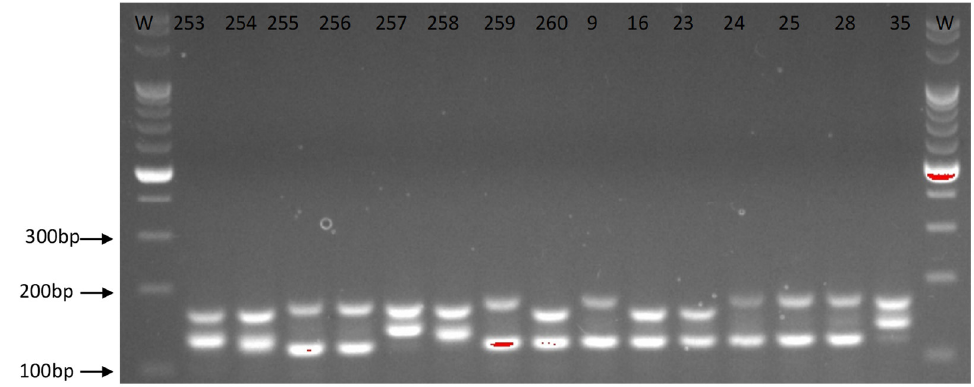
Figure 7. Electrophoretic image of PCR products after including bnlg1621 and umc2059 primer pairs in the reaction.